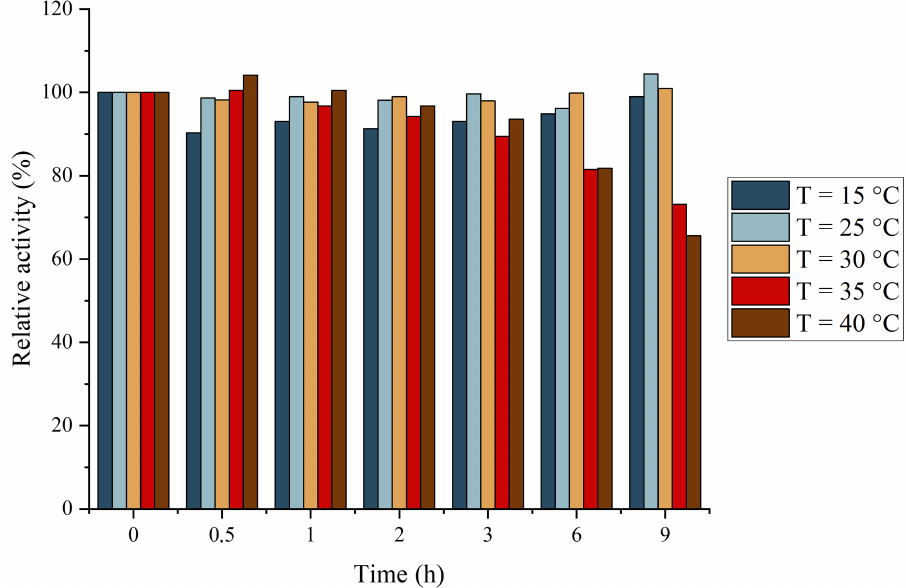
Figure 2. Change of relative activity at different temperatures (Conditions: laccase concentration = 3 mg·mL − 1 , pH = 4, constant mixing in thermostatic cabinet without membrane, initial activity was considered as